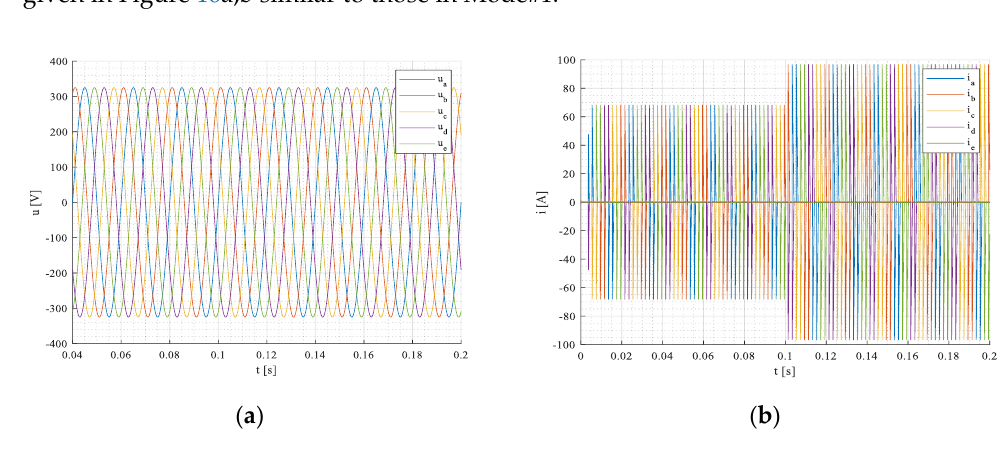
given in Figure 16a,b similar to those in Mode#1.